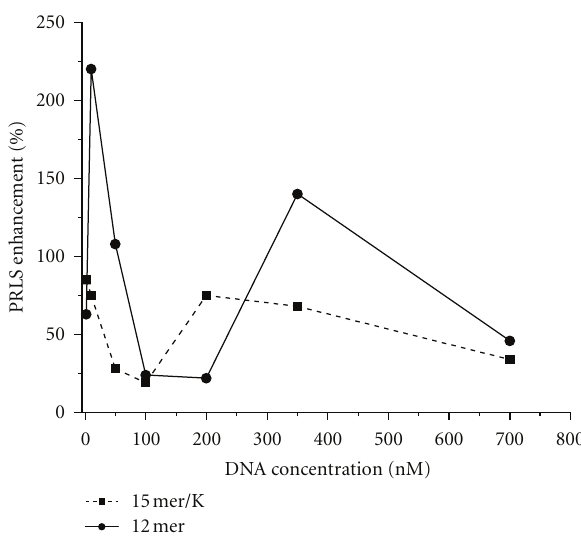
Figure 3: PRLS intensity of gold nanoparticles at 540nm, measured when di ff erent concentrations of 15 mer DNA (with K + ) and 12mer were